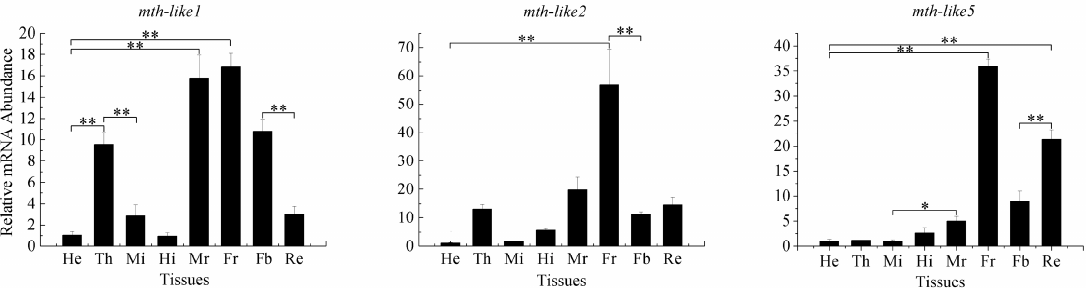
Figure 4. Tissue expression profiles of mth-like genes. The relative expression indicates the level of each mth-like transcript normalized to the internal standard of EF-1 α , compared to the expression level of head. Data are shown as the mean ± SD. Asterisks indicate differences that are statistically significant (*, p < 0.05; **, p < 0.01). He, head; Th, thorax; Mi, midgut; Hi, hindgut; Mr, male reproductive system; Fr, Female reproductive system; Fb, fat body; Rb, residual body.